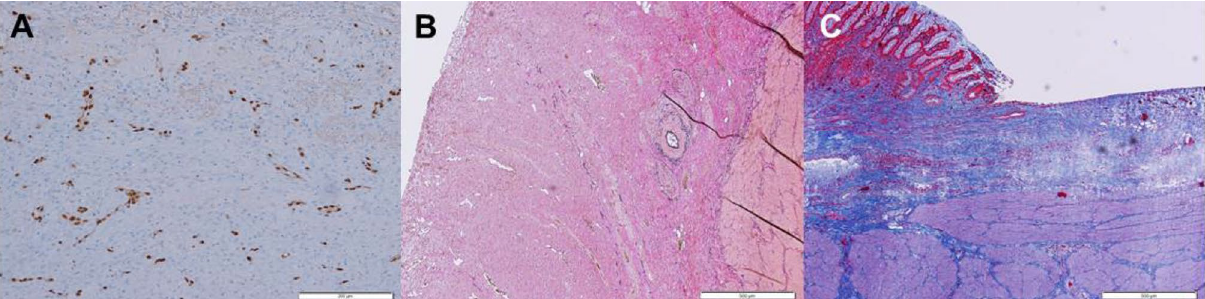
Figure 3. Analysis of histological parameters. ( A ) Immunohistochemistry (ERG staining of ulcer ground, white bar indicates 200 µm); ( B ) Elastica-van-Gieson staining of ulcer ground (white bar indicates 500 µm); ( C ) Masson-Trichrome staining of the ulcer margin (white bar indicates 500 µm). ERG member of the ETS family of transcription